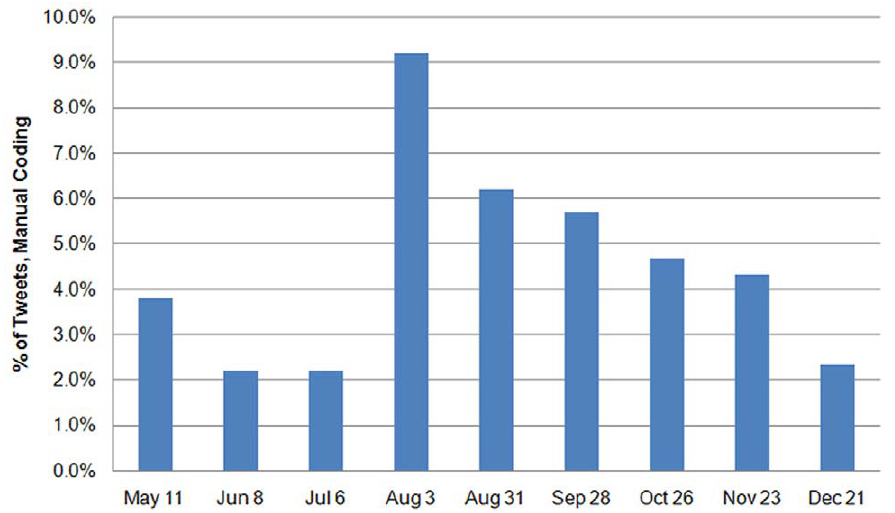
Figure 2. Non-linear pattern of tweeted misinformation identified via manual coding from May to December 2009.